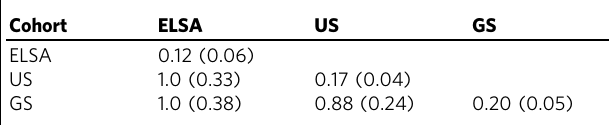
Table 2 Genetic correlations and heritability estimates of a general cognitive function component in three United Kingdom cohorts